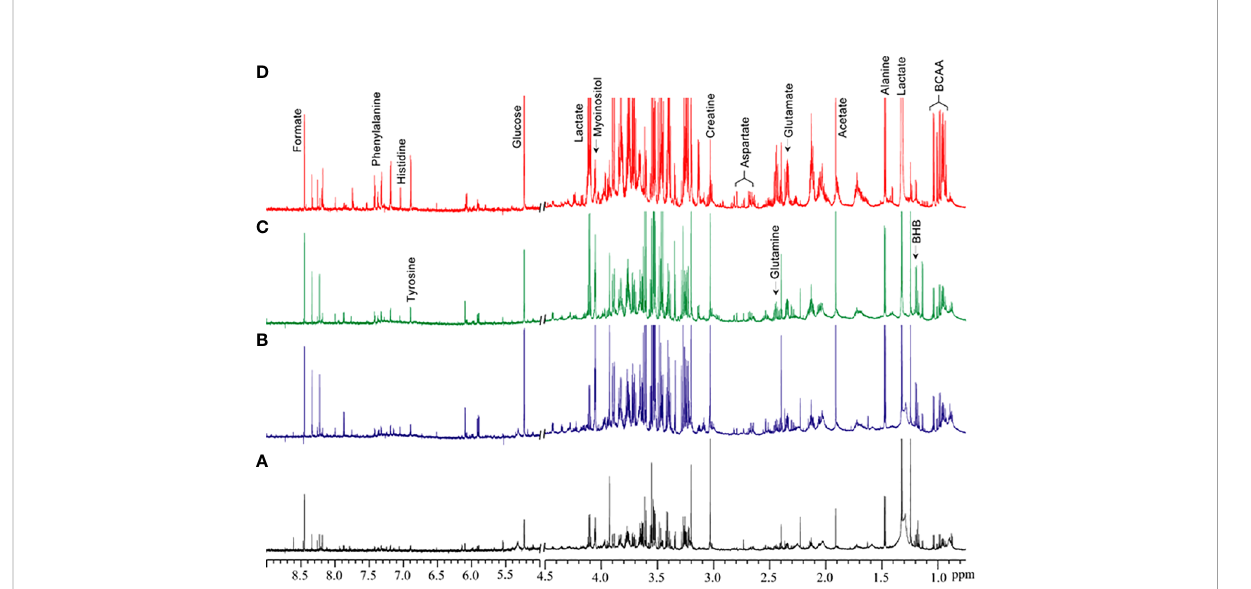
FIGURE 1 Representative 1 H MR spectra showing metabolic differences in aqueous-phase extracts of tumor tissue obtained from (A) normal fat, (B) benign lipoma (BL), (C) atypical lipomatous tumor (ALT), and (D) dedifferentiated liposarcoma (DDL). Normal fat tissues are non-involved tissues obtained during tumor excision surgery. BCAA, branched chain amino acids; BHB,